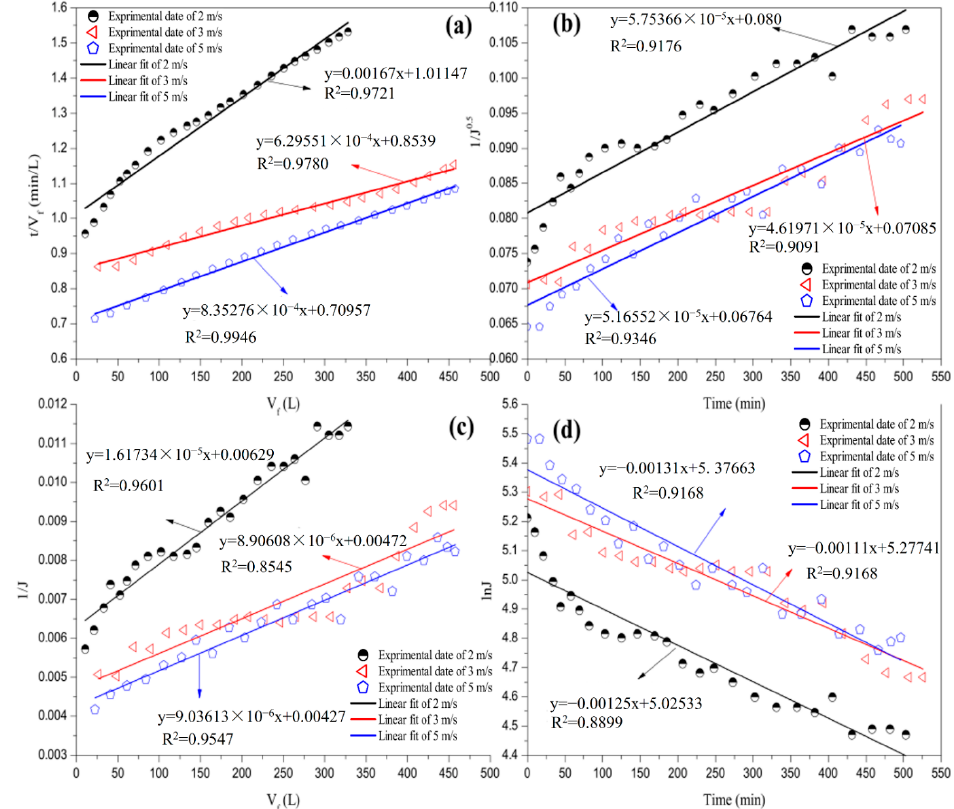
Figure 7. Linear fit with four fouling models at various CFVs: ( a ) cake filtration; ( b ) pore narrowing; ( c ) combination of external and progressive internal fouling; and ( d ) complete pore blocking.